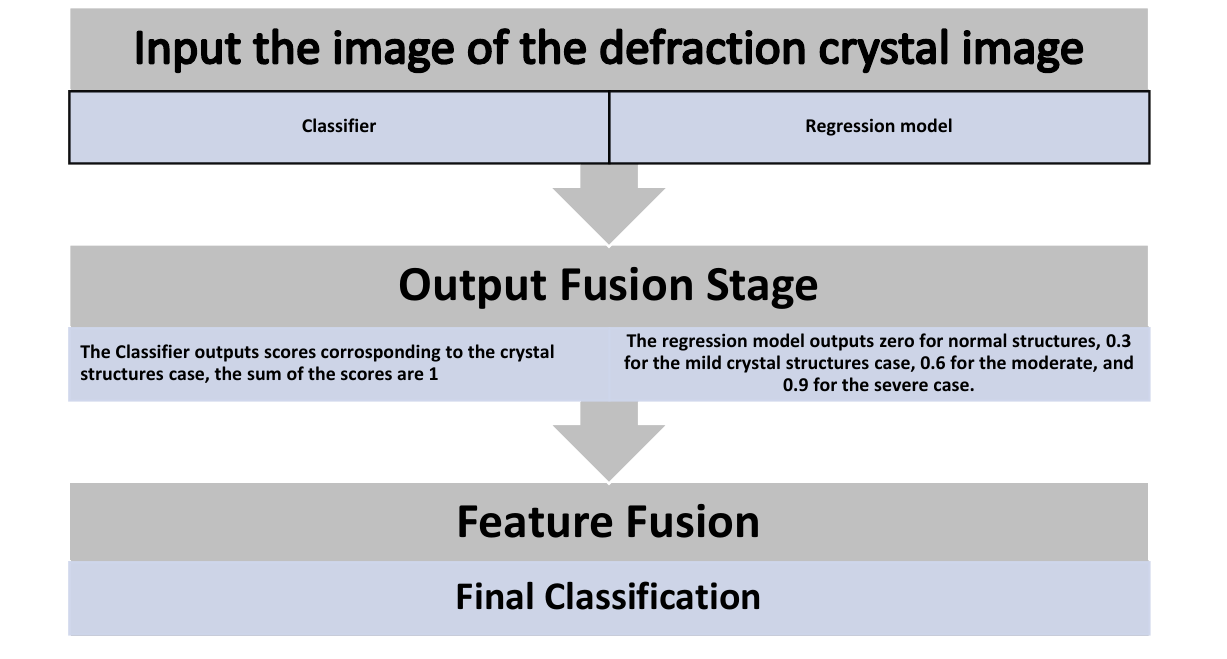
Figure 2. The proposed classifier and regression model, the images of the diffraction crystal images are fed as input for both the classifier and the regression model, and the outputs from both models are then fused.